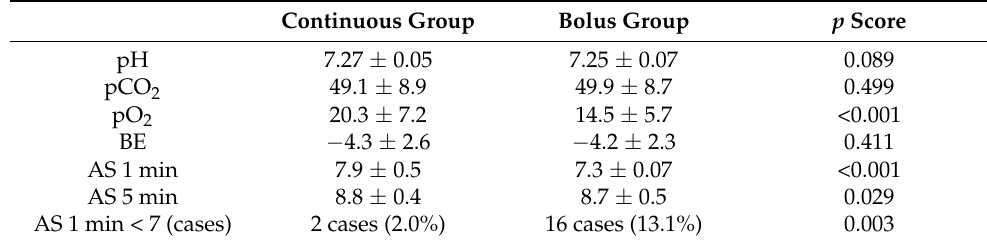
Table 3. The results of the neonatal-related parameters.